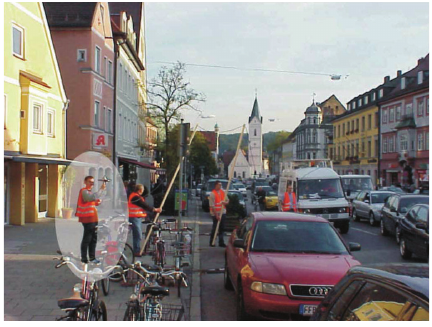
Figure 4: Pedestrian measurement scenario in suburban environ- ment (F¨urstenfeldbruck).